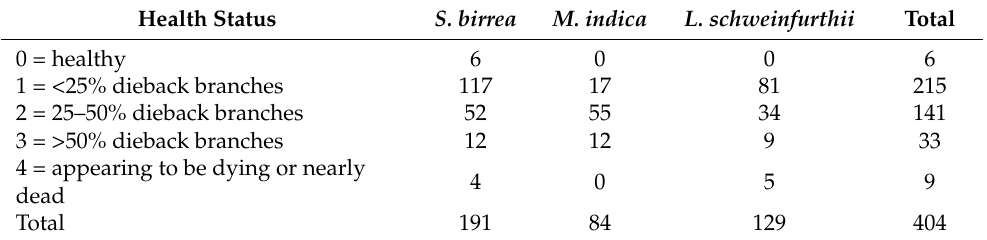
Table 2. Health status of the three tree species of Anacardiaceae assessed in this study.